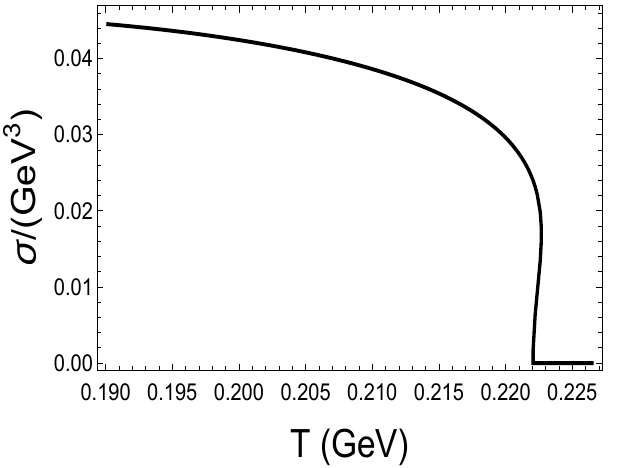
Figure 5. Chiral condensate (cid:27) in chiral limit ( m q = 0) as a function of the temperature T for V ( (cid:31); F 2 ) = (cid:0) 3 (cid:31) 2 + v 4 (cid:31) 4 + v 6 (cid:31) 6 with v 4 = (cid:0) 2 ; v 6 = 100 and (cid:22) = 0 : 5 2